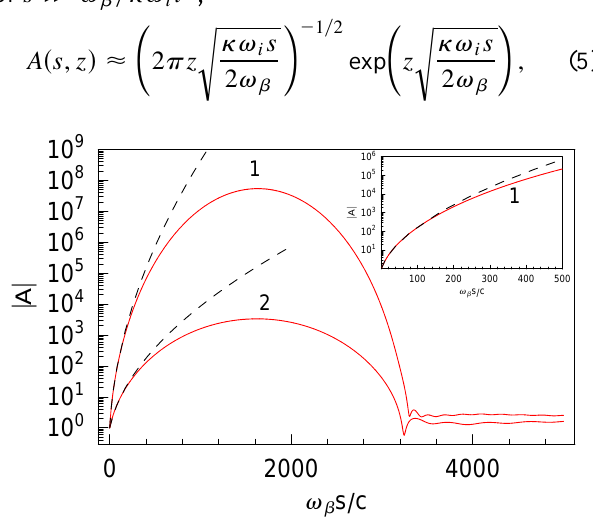
FIG. 1. (Color) Numerical solution of Eq. (1), A (cid:1) s (cid:2) , for z (cid:1) l (curve 1) and z (cid:1) l (cid:3) 2 (curve 2). Dashed curves show the respective analytical solution A (cid:1) s , z (cid:2) (cid:1) I 0 (cid:1) z p k v i s (cid:3) 2 v b (cid:2) . The inset shows the magnified part of curve 1 with its asymptotic